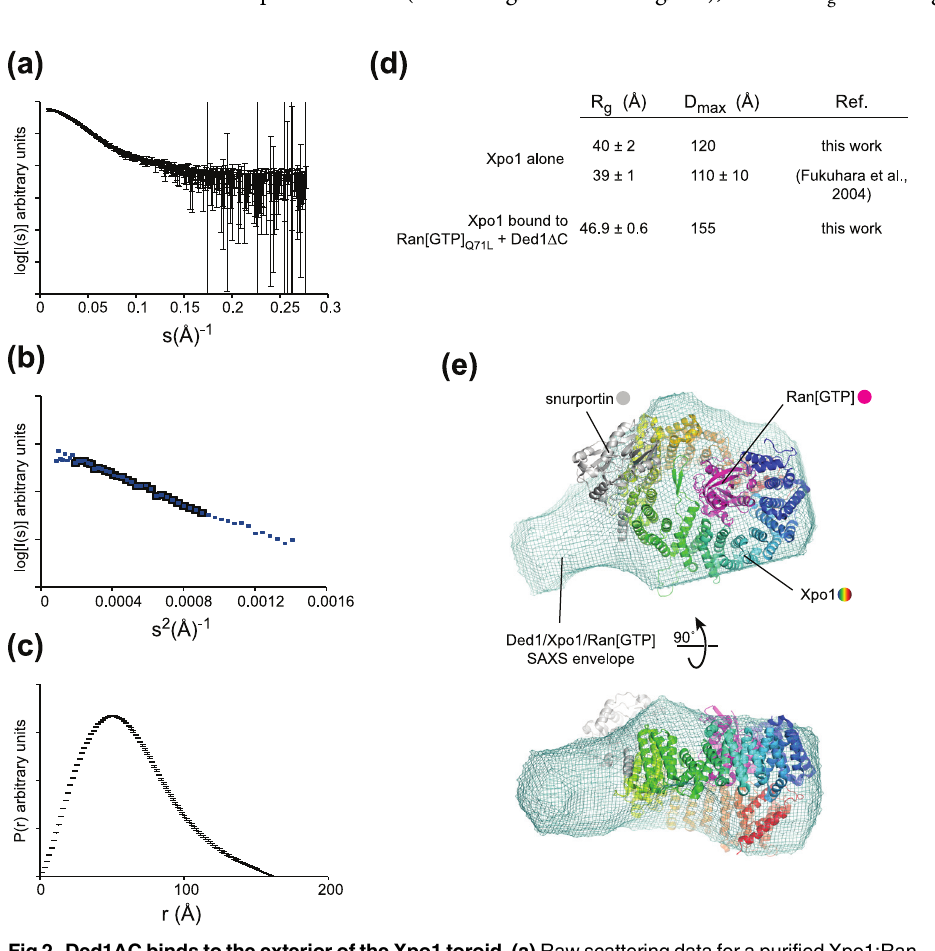
Fig 2. Ded1 Δ C binds to the exterior of the Xpo1 toroid. (a) Raw scattering data for a purified Xpo1:Ran [GTP] Q71L :Ded1 Δ C complex. (b) Gunier plot for the raw data in (a). The black squares indicate the linear Gunier region. (c) P(r) curve for the raw data in (a). (d) R g and D max values calculated for Xpo1 alone and in the presence of Ran[GTP] Q71L and Ded1 Δ C. Published values are taken from ref. [33]. (e) A putative docking of the crystal structure of snurportin 1 bound to Xpo1 and Ran[GTP] (3GJX; [13]) with an averaged, filtered bead model calculated for the Xpo1: Ded1 Δ C:Ran[GTP] Q71L